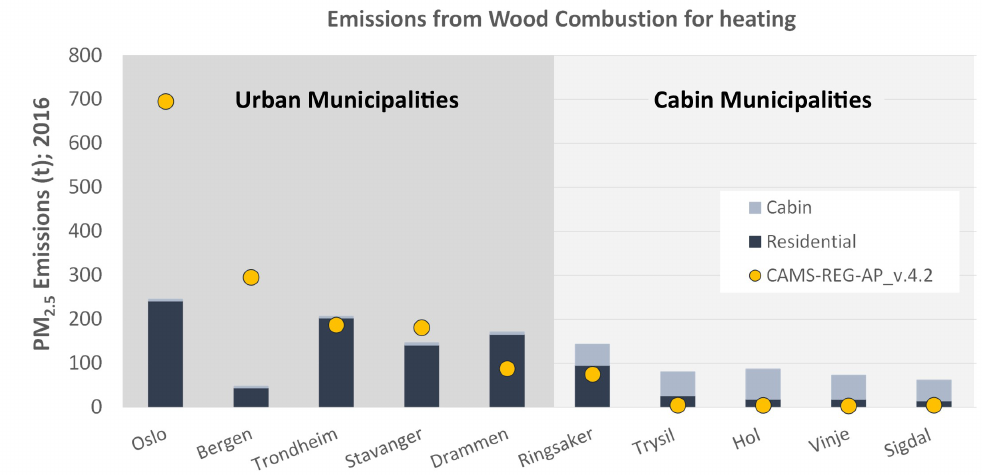
Figure 8. PM 2.5 Emissions from residential and cabin wood combustion estimated in our study (Bars) compared with CAMS-REG-AP emissions (NFR Sector: Residential: Stationary) for the residential sector (version 4.2) for urban municipalities and cabin